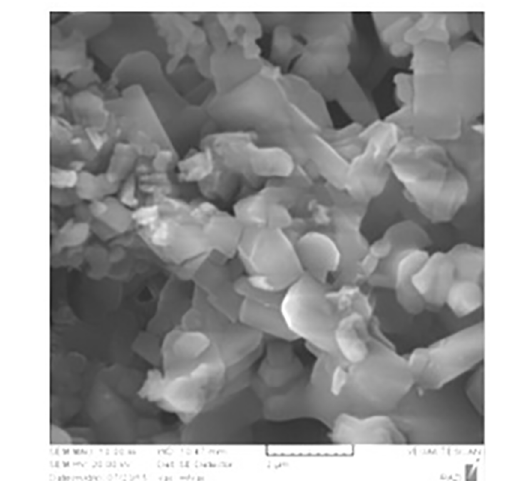
Figure 4. SEM image of calcined materials in 700 ºC